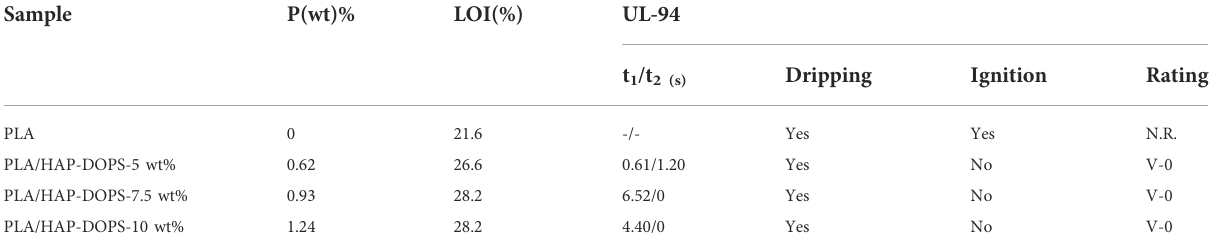
TABLE 2 LOI and UL-94 test data of PLA and PLA composites.